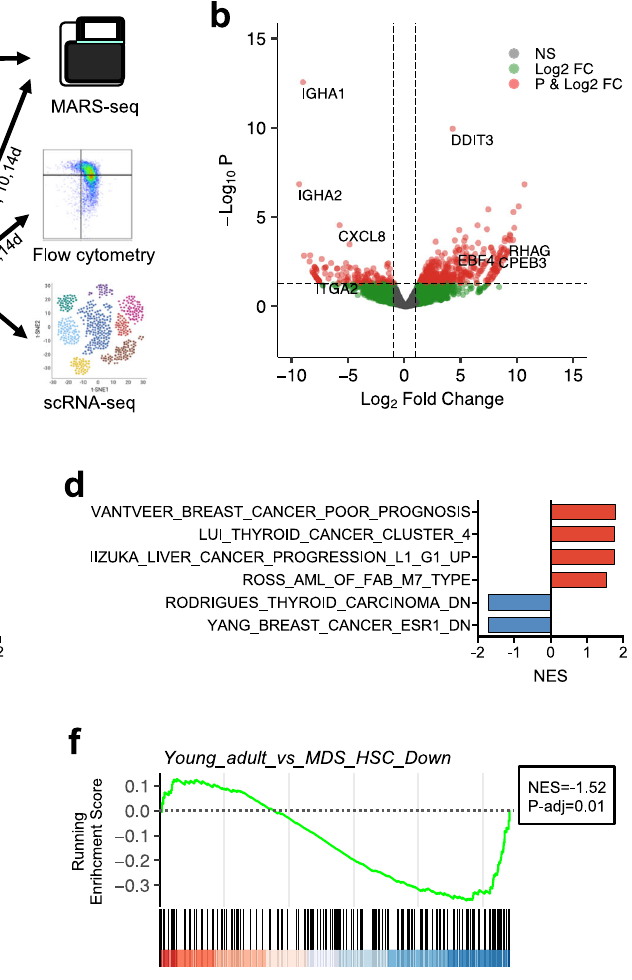
HSCs. Green points represent genes with |FC|>2, red points depict genes with |FC|>2 and FDR<0.05 and grey points indicate genes with no relevant changes in expression. Several genes with signi fi cant up- and down-regulation are indicated. Statistical values of differential expression were calculated with DEseq2, and plot- ted using EnhancedVolcano library. c , d GSEA of cells overexpressing DDIT3 and controlHSCs.TheNESforseveralsignaturesrelatedtogeneralbiologicalprocesses ( c ) and cancer-related signatures ( d ) are depicted. e , f GSEA plots depicting the enrichment upon DDIT3 overexpression in gene signatures representing genes up- and down-regulated in HSCs from MDS patients when compared to those from young healthy adults. GSEA was performed with the GseaPreranked tool. The NES and adjusted p values are indicated for each